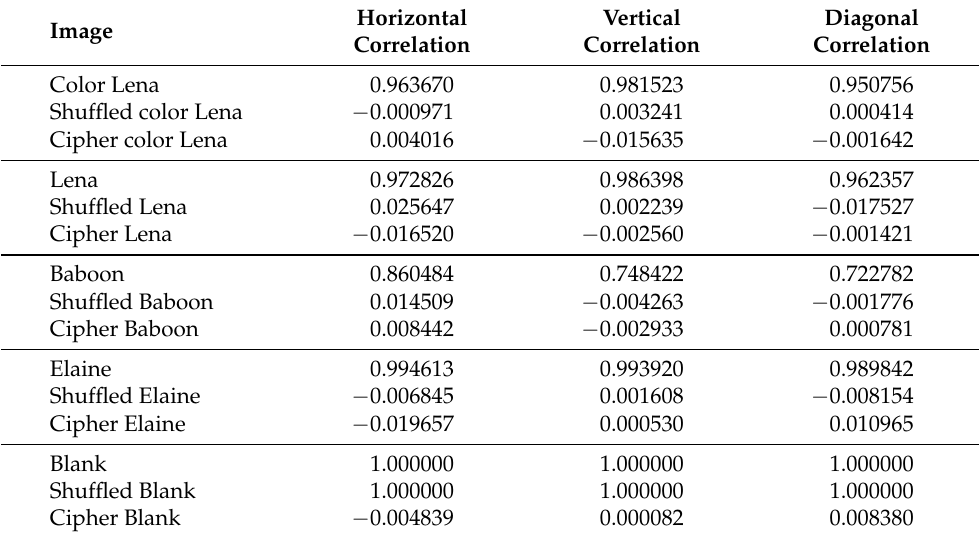
Table 3. Correlation coefficients of adjacent pixels in different test images and their corresponding shuffled and cipher